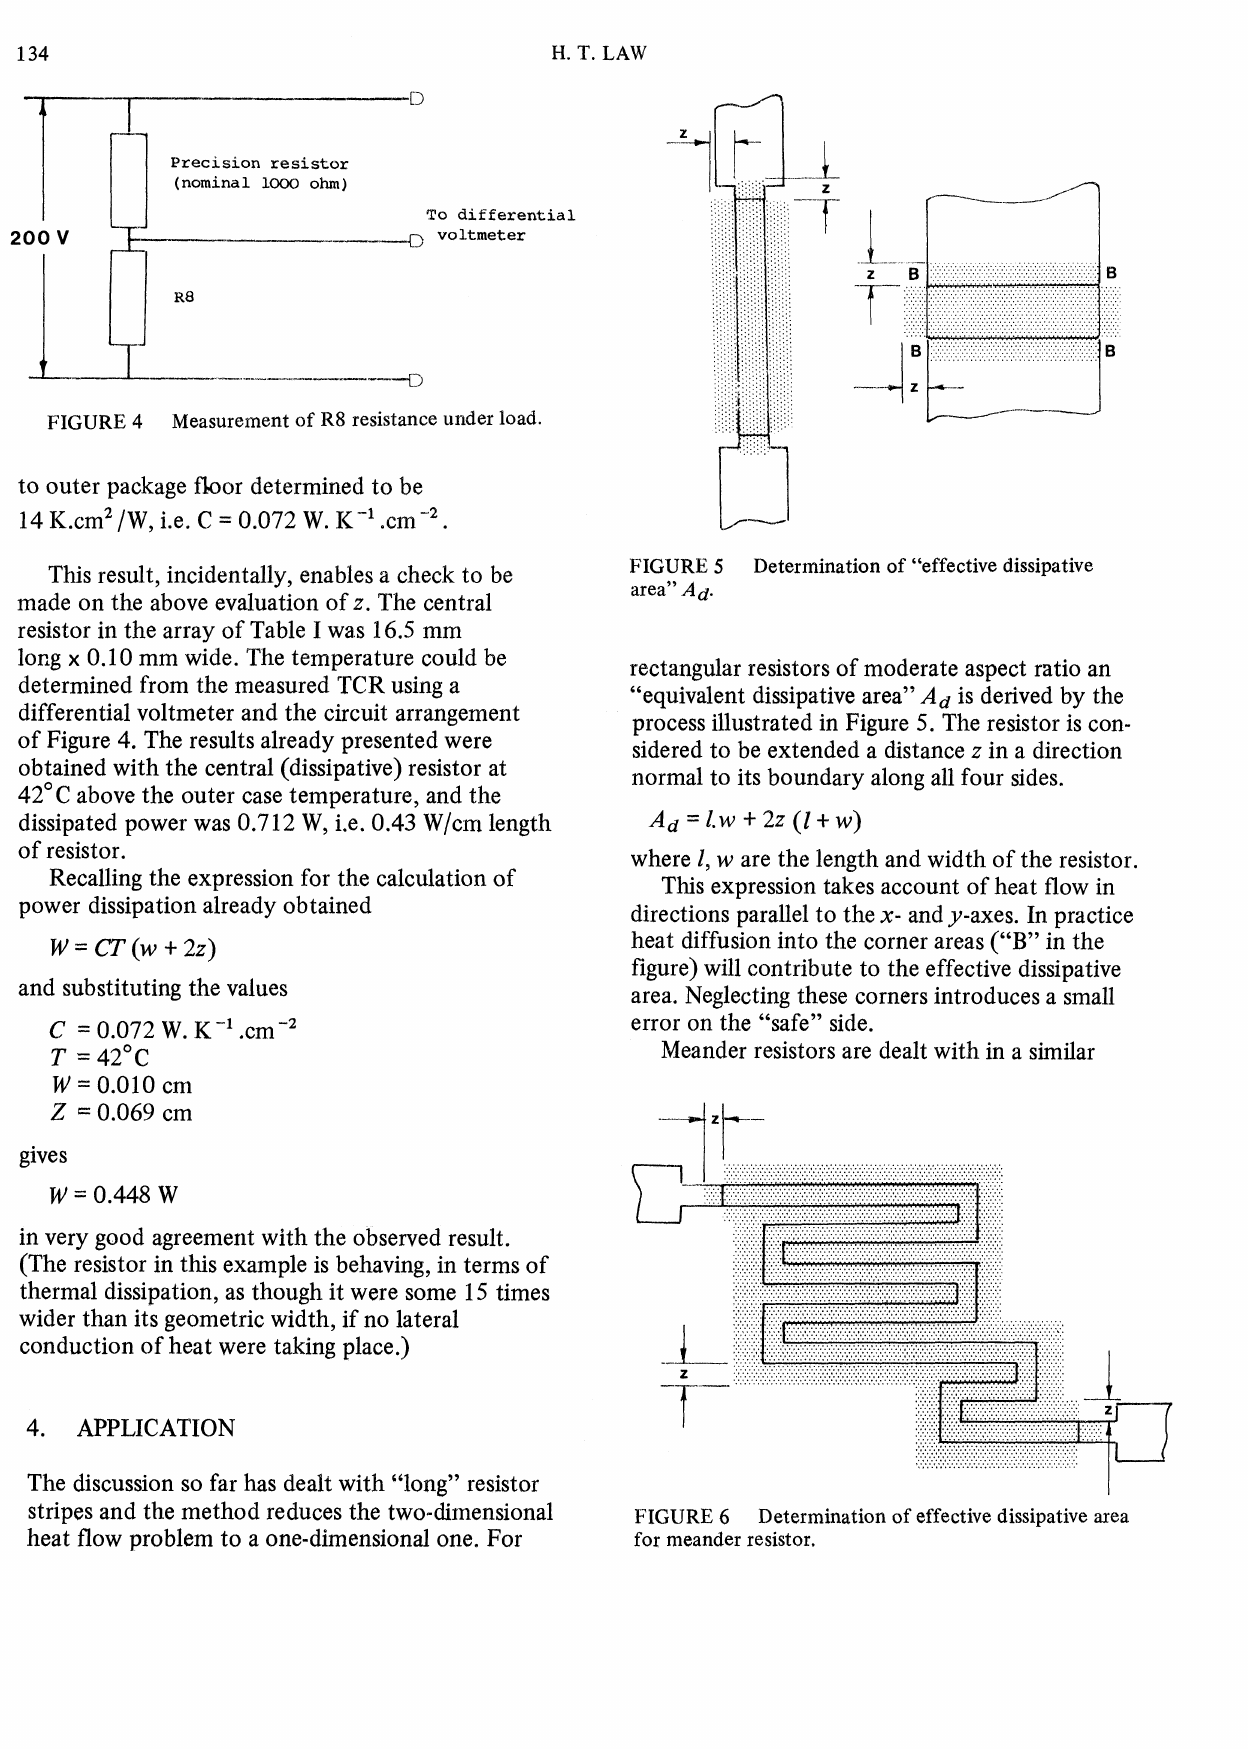
FIGURE 4 Measurement of R8 resistance under load.